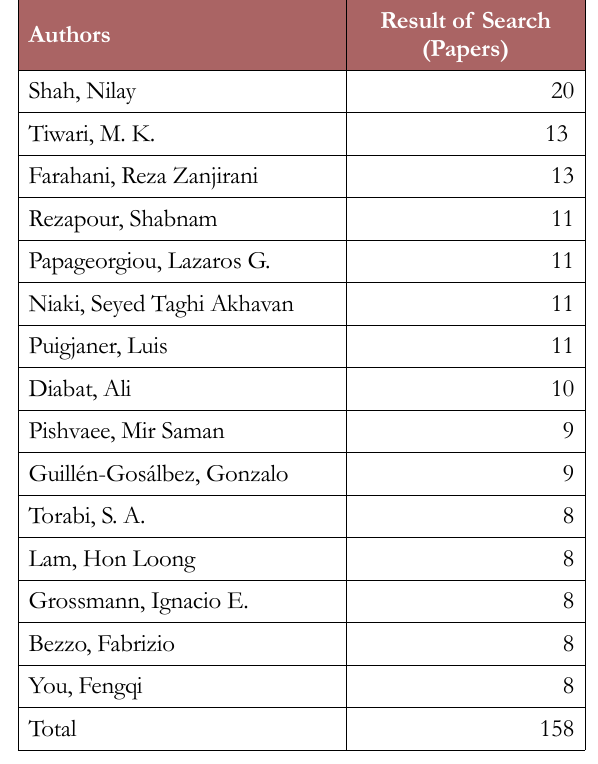
Table 4. The authors with 8 or more